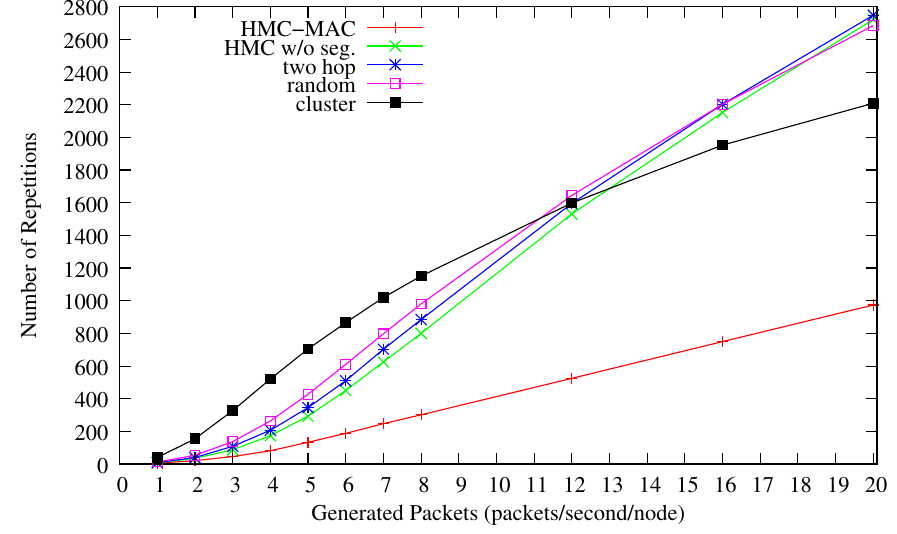
Figure 13. Number of repetitions for periodic